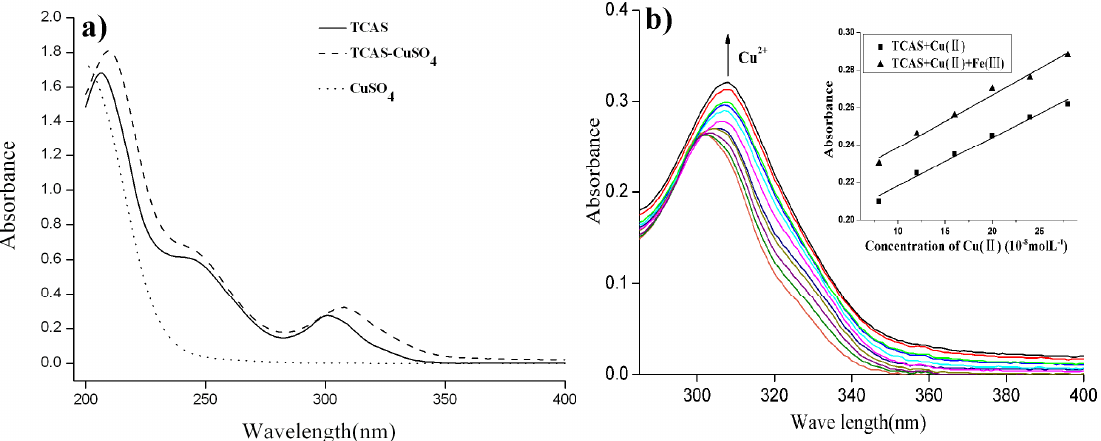
Figure 2. ( a ) Absorption spectra of TCAS (4.5 × 10 − 5 mol · L − 1 ), CuSO 4 , and TCAS-CuSO 4 aqueous solution; ( b ) effect of Cu(II) concentration on absorbance at 312nm and linear relation in Cu(II) concentration range of 0.8–2.8 × 10 − 7 mol · L − 1 with and without Fe(III) ion (shown in the inserts).